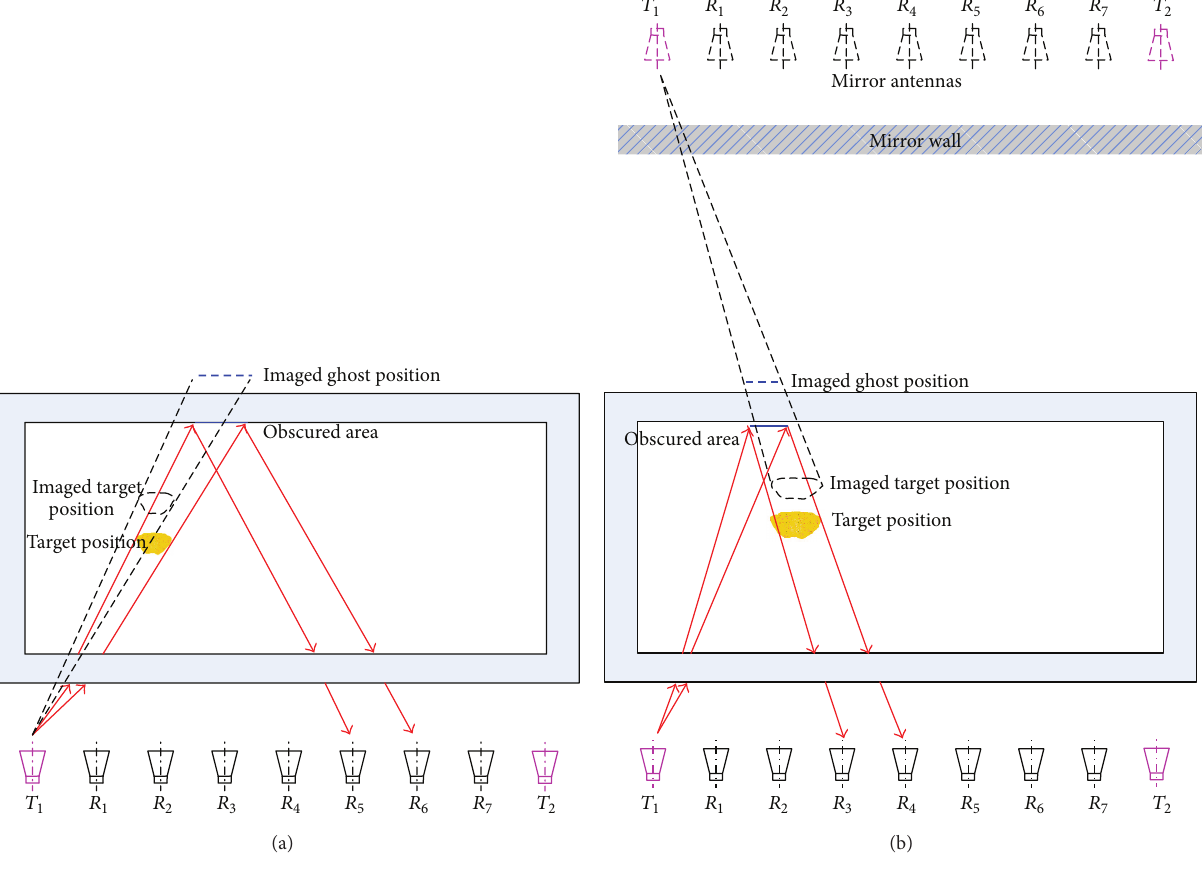
Figure 3: Spatial relationship among the antenna (or mirror antennas), target, and ghost in MIMO mode. (a) Ghost occurs in the first case. (b) Ghost occurs in the second case.